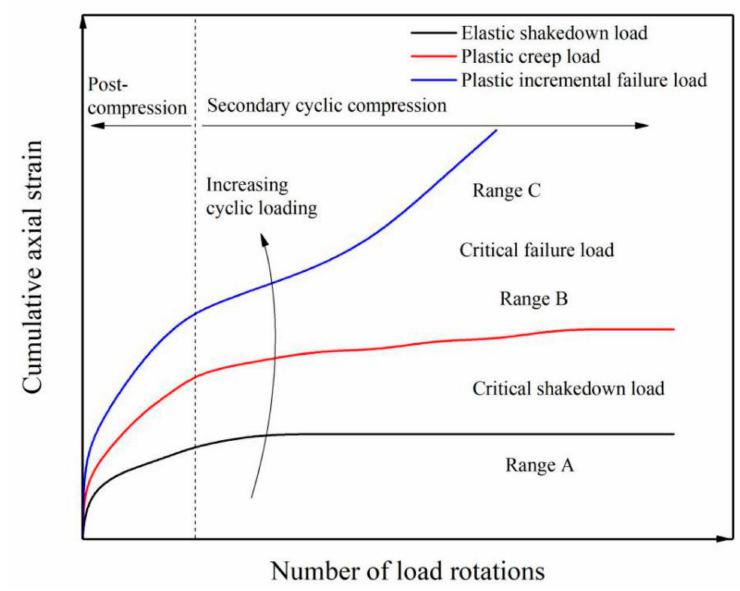
Figure 1. Deformation behavior of granular material under cyclic